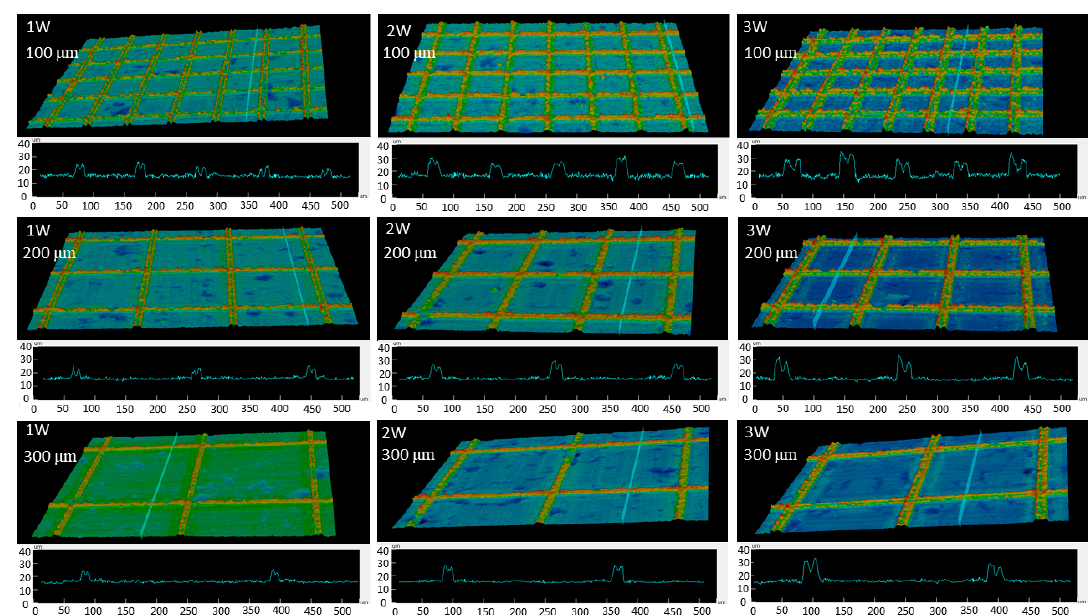
Figure 3. Confocal microscopy images of the grid-patterned samples with a step size of 100, 200, and 300 µm at a laser power of 1, 2, and 3 W.